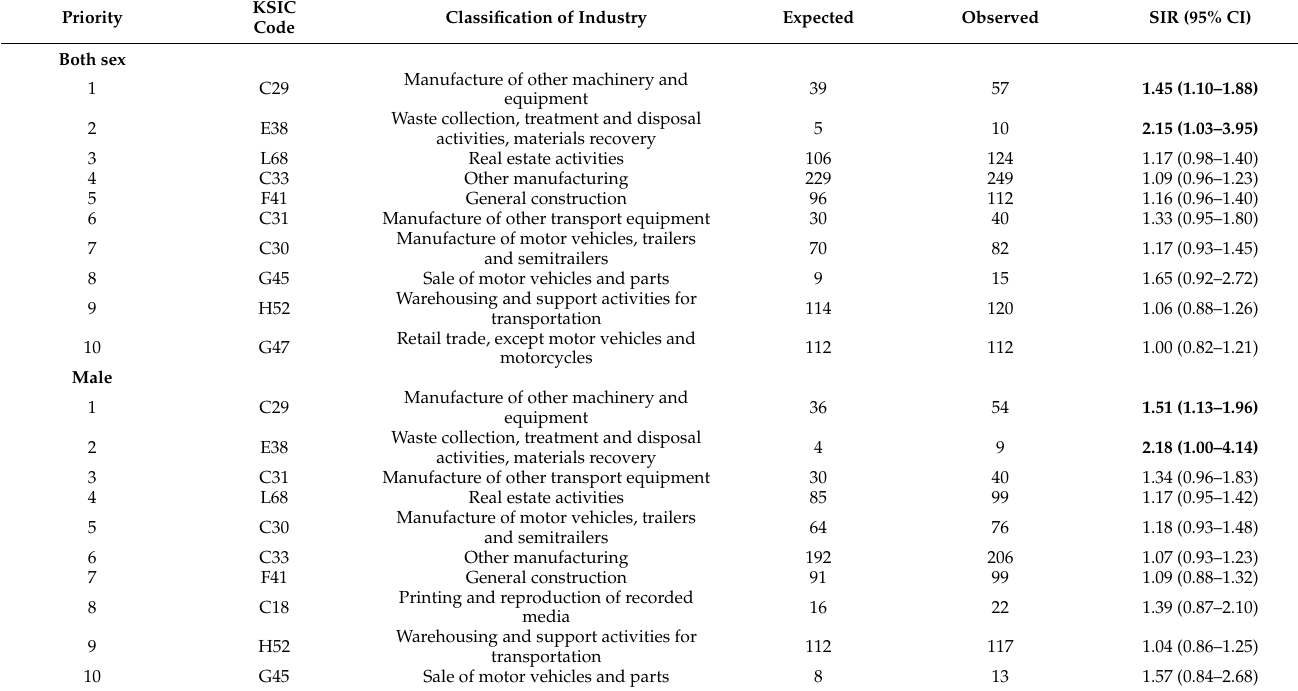
Table 4. Top 10 priority KSIC divisions with a high risk of leukemia as assessed by age-standardized incidence ratios (SIRs) and a 95% confidence interval (95%